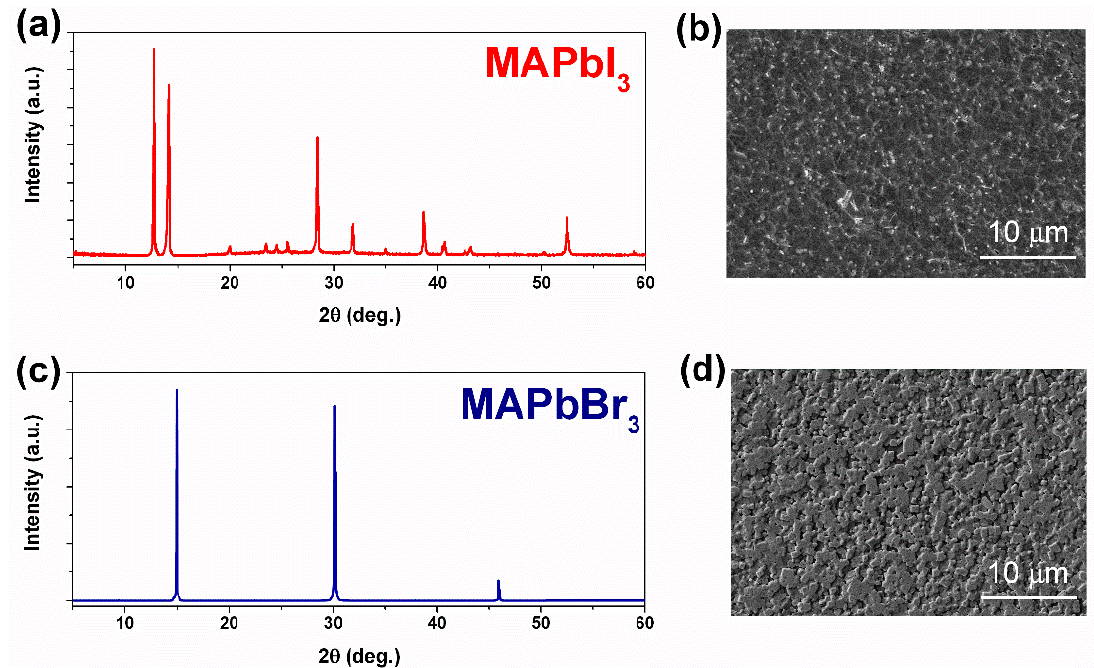
Figure 1. Typical XRD spectra and SEM images of fabricated polycrystalline MAPbI 3 ( a , b ) and MAPbBr 3 ( c , d ) films.